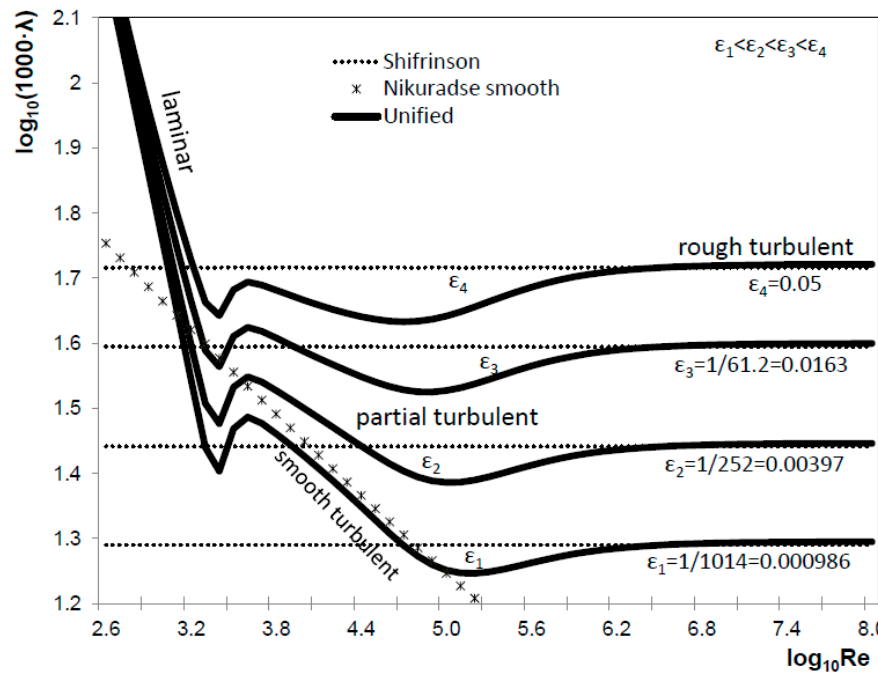
Figure 10. The unified hydraulic model II; Equation (15).